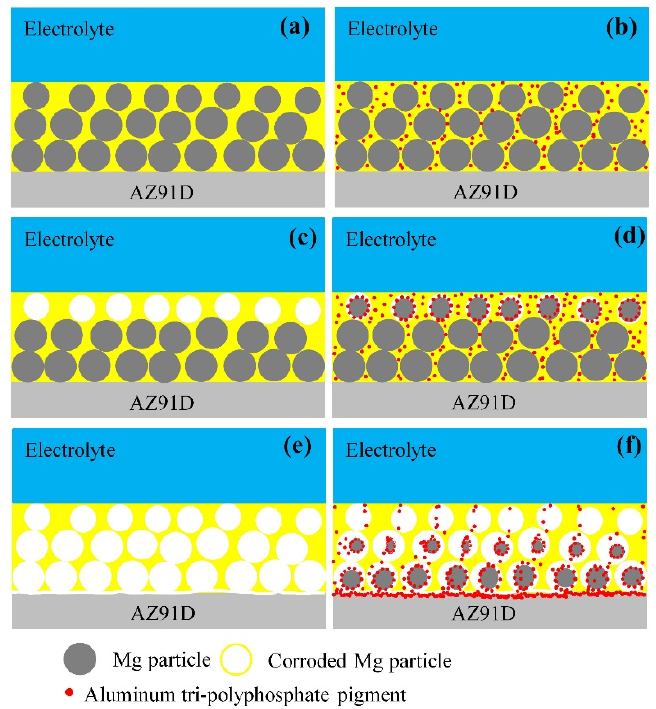
Figure 11. Schematic diagrams illustrating the mechanisms of MRP and SAP-MRP samples in the simulated acid rain solution: ( a ) MRP in the initial stage; ( b ) SAP-MRP in the initial stage; ( c ) MRP in the stable stage; ( d ) SAP-MRP in the stable stage; ( e ) MRP in the late stage; ( f ) SAP-MRP in the late stage.